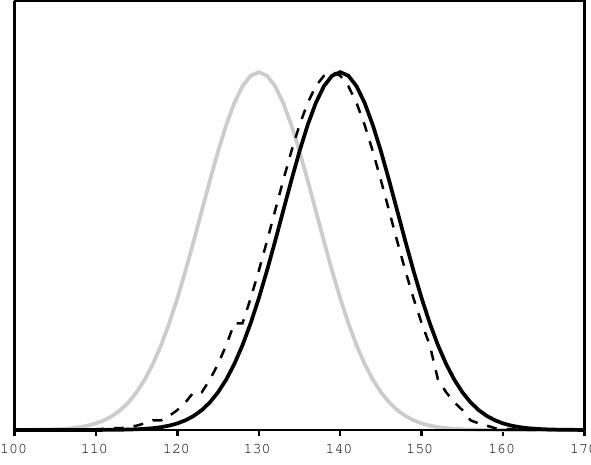
Fig. 1. Illustration of the translation method applied to an ideal- ized function. The observed vector y o (solid black curve) and the background x b (solid light-grey curve) are bell-shaped functions, centered at different positions. The translated background resulting from the step-1 method is in dash. The algorithm uses the following parameters: w 1 = 1 . 5 × 10 − 3 , w 2 = 4, corresponding to a typical position error of 10 grid points, like in the following parts of the article. H is the identity matrix.